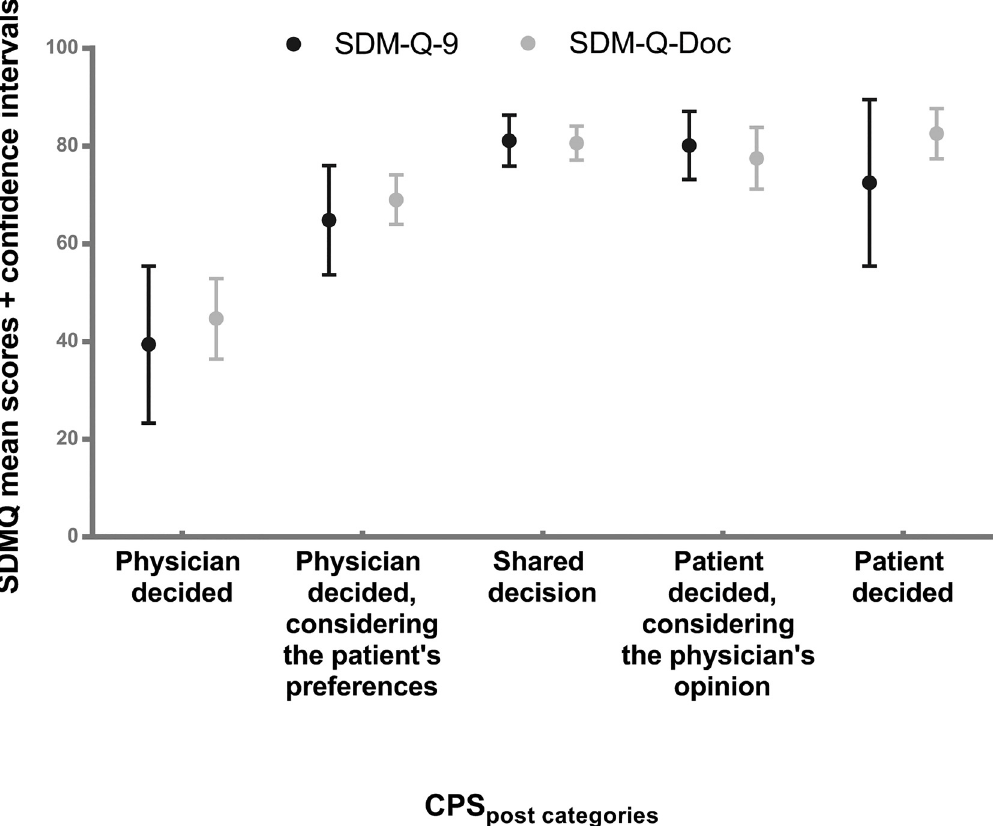
Fig 2. Mean scores and confidence intervals of the SDM-Q-9 and SDM-Q-Doc by category of the Control Preferences Scale.